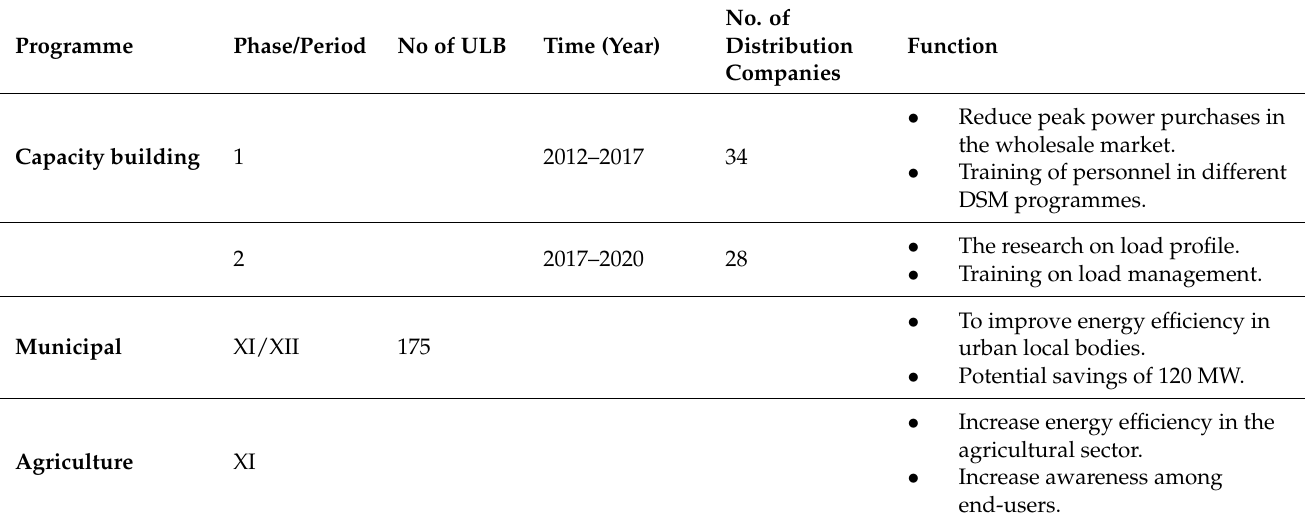
Table 6. DSM programmes in India